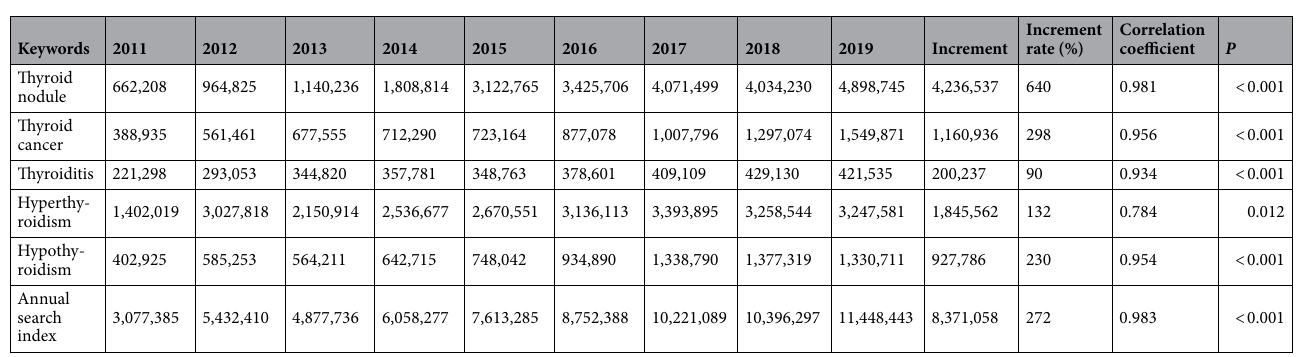
Table 1. Basic situation and correlation analysis of search index from 2011 to 2019.